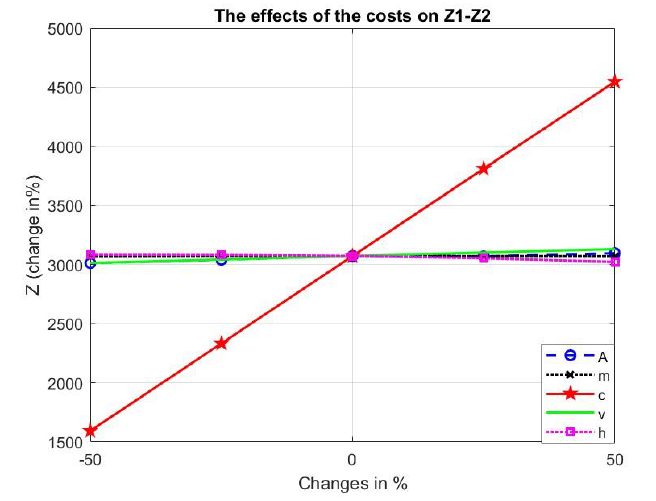
Figure 9. The effects of the cost of the numerical example on the difference between the two models.